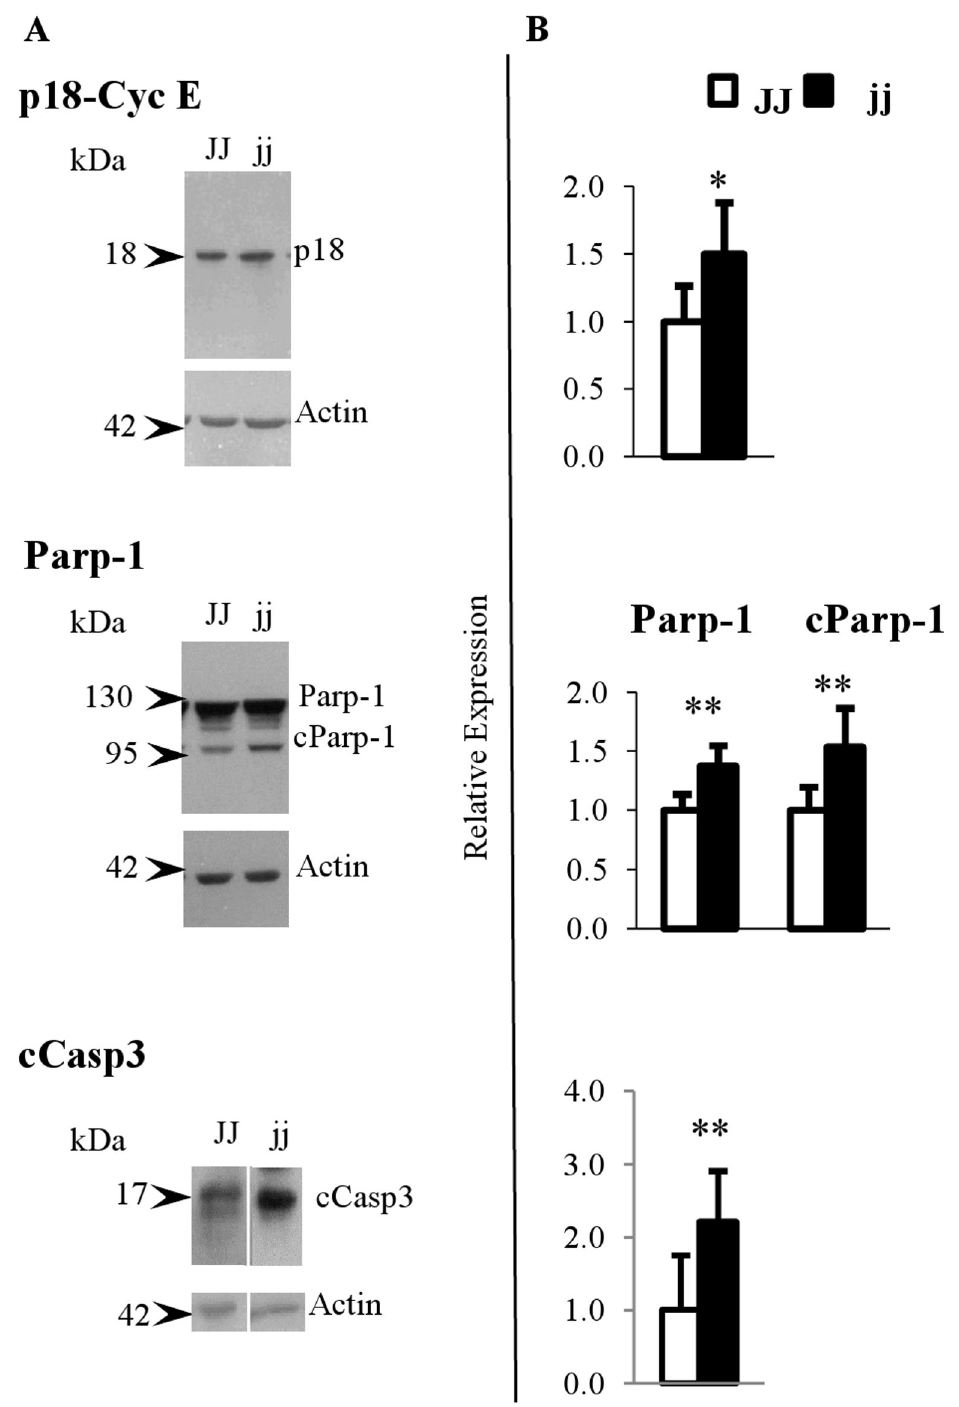
Figure 4. Representative Western blot and protein relative expression of p18-Cyclin E, Parp-1, cParp-1 and cCasp3. A) Representative Western blot, and B) protein relative quantification. cParp-1 : cleaved Parp-1. cCasp3 : active caspase3 □ Normal homozygous JJ and ■ Hyperbilirubinemic homozygous jj Gunn rat. Data are expressed as mean ± SD. Statistical significance: * p < 0.05, ** p < 0.01.